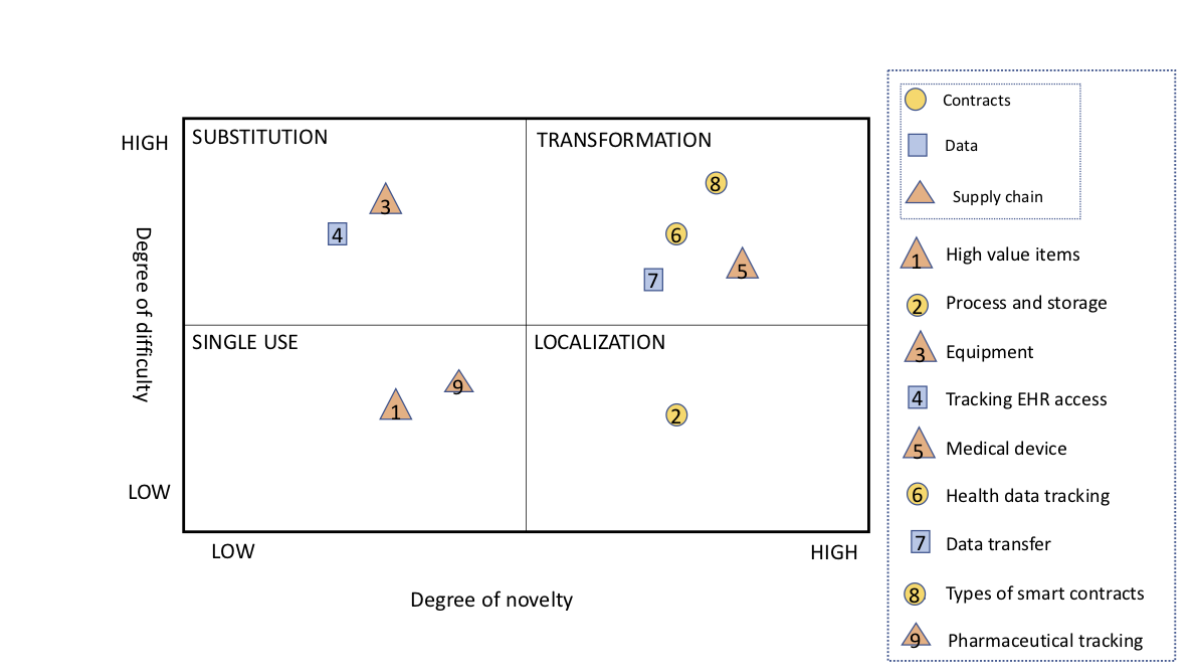
Figure 5. Evaluation of the proposed applications using Marco’s framework. EHR: electronic health